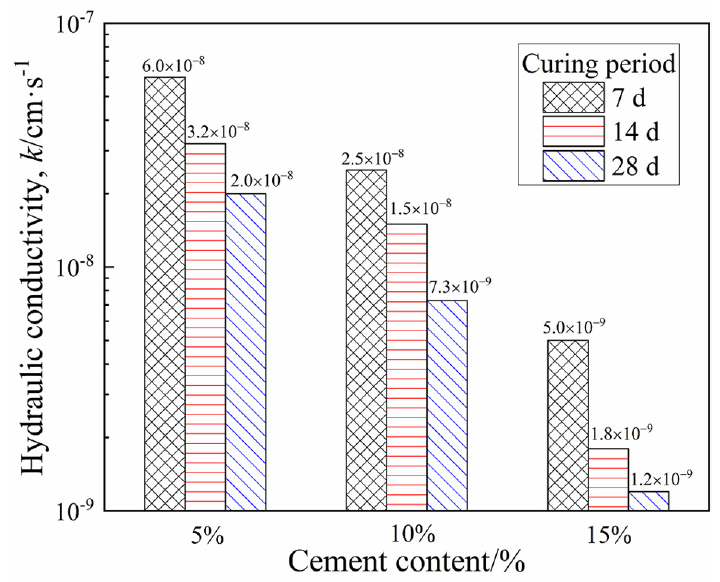
Figure 14. The hydraulic conductivity of CDS.